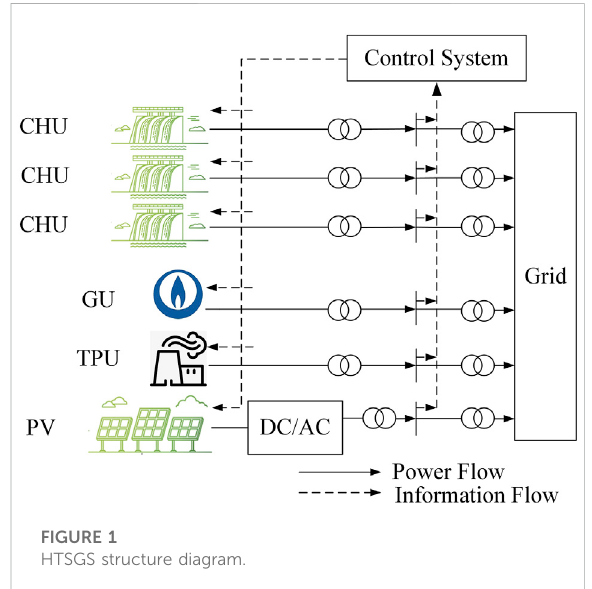
FIGURE 1 HTSGS structure